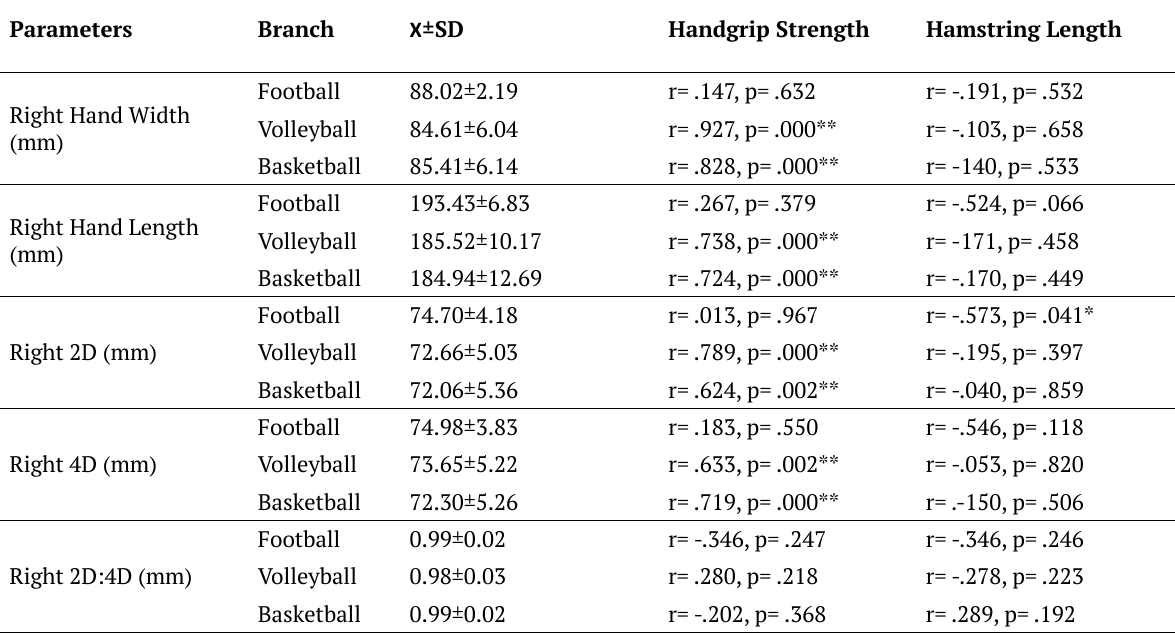
Table 2. The Relationship between Participants’ Right Hand Parameters and Hand Grip Strength and Hamstring